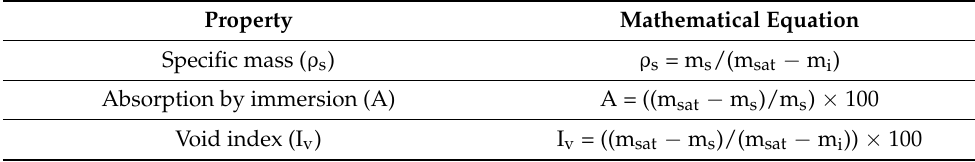
Table 1. Mathematical formulations to obtain the